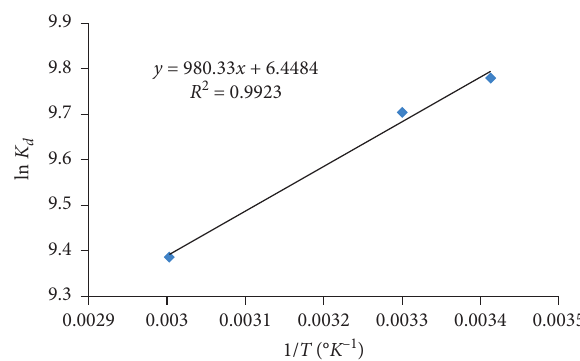
Figure 14: Van’t Hoff curve for the adsorption of phenol on Sale clay. Table 8: Thermodynamic parameters of phenol